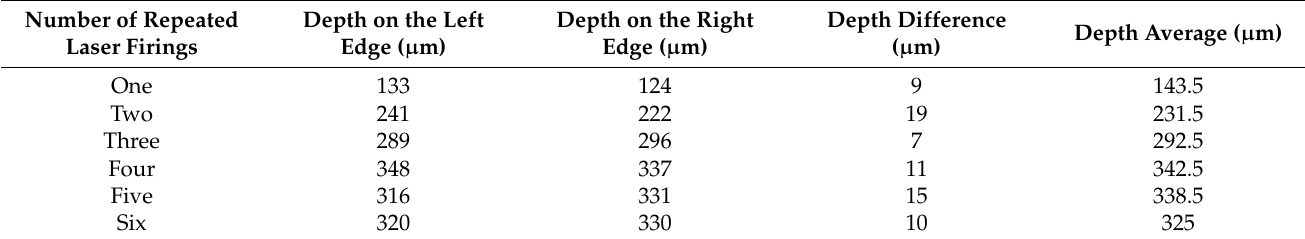
Figure 12. The cross sections of samples trimmed for different numbers of repeated laser firings with the 5.5w_30k_300_re50 recipe (no metal surface): ( a ) one; ( b ) two; ( c ) three; ( d ) four; ( e ) five; and ( f ) six repetitions. Table 3. The measured depth values after different numbers of repeated laser firings with the 5.5w_30k_300_re50 (no metal surface) recipe.